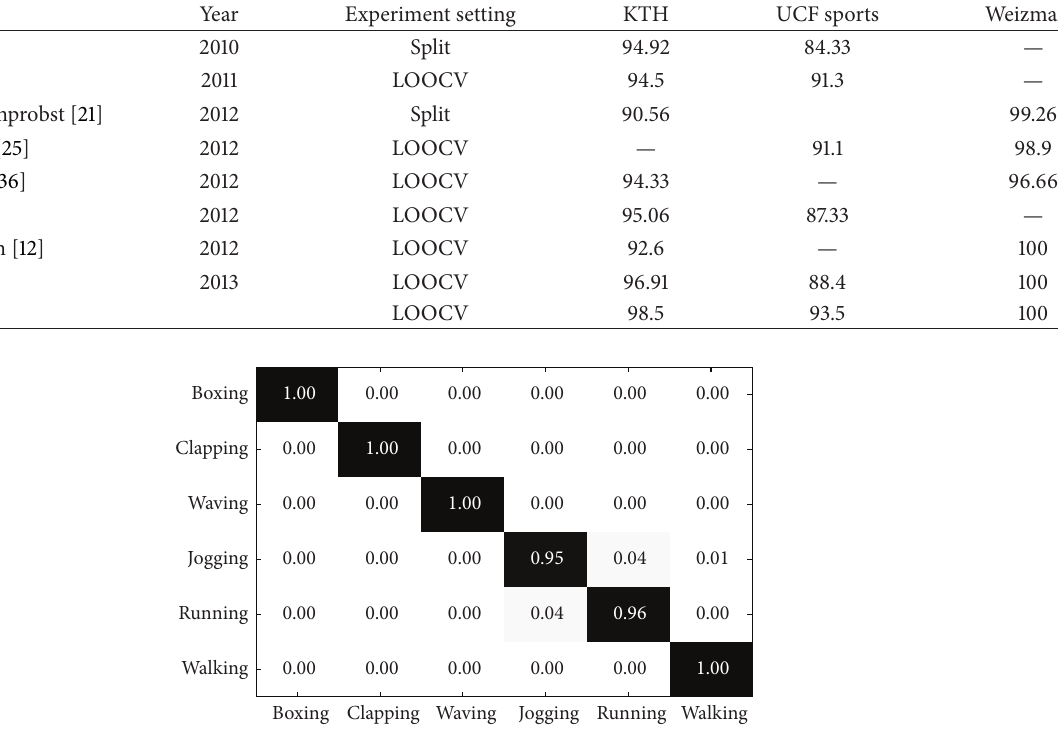
Table 4: Comparison results with other methods (unit: %).